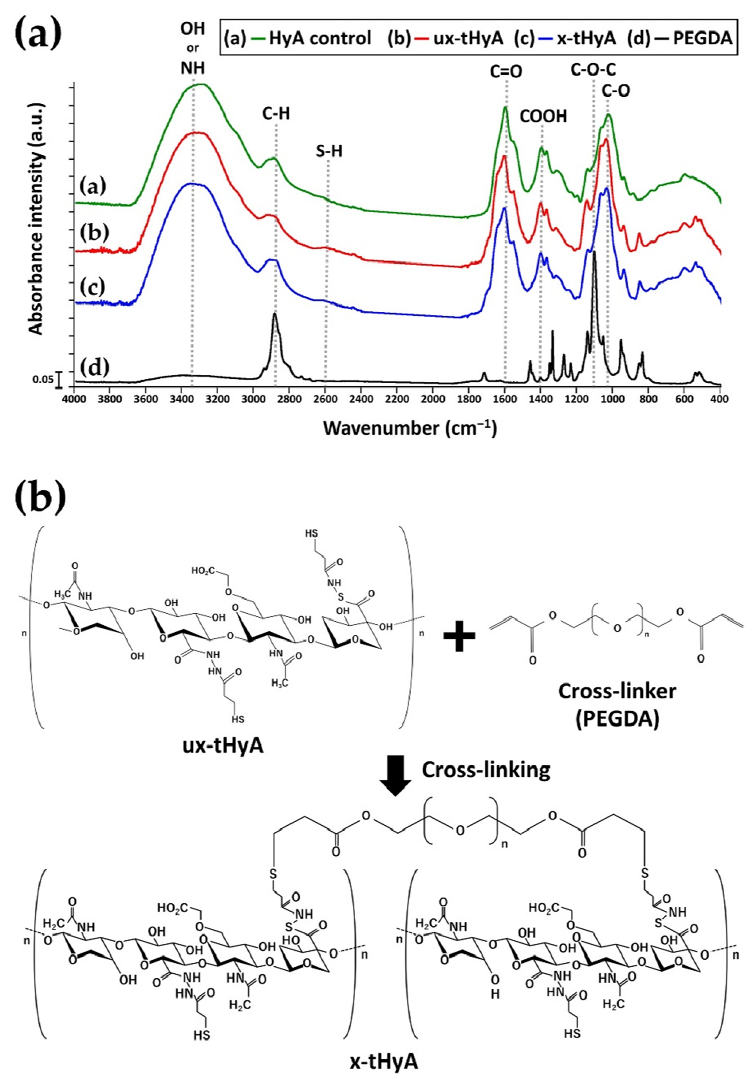
Figure 7. ( a ) FTIR charts of dried (i) HyA control, (ii) ux-tHyA, (iii) x-tHyA, and (iv) PEGDA cross-linker. ( b ) Chemical structures of ux-tHyA with detailed side chains, PEGDA cross-linker and x-tHyA.